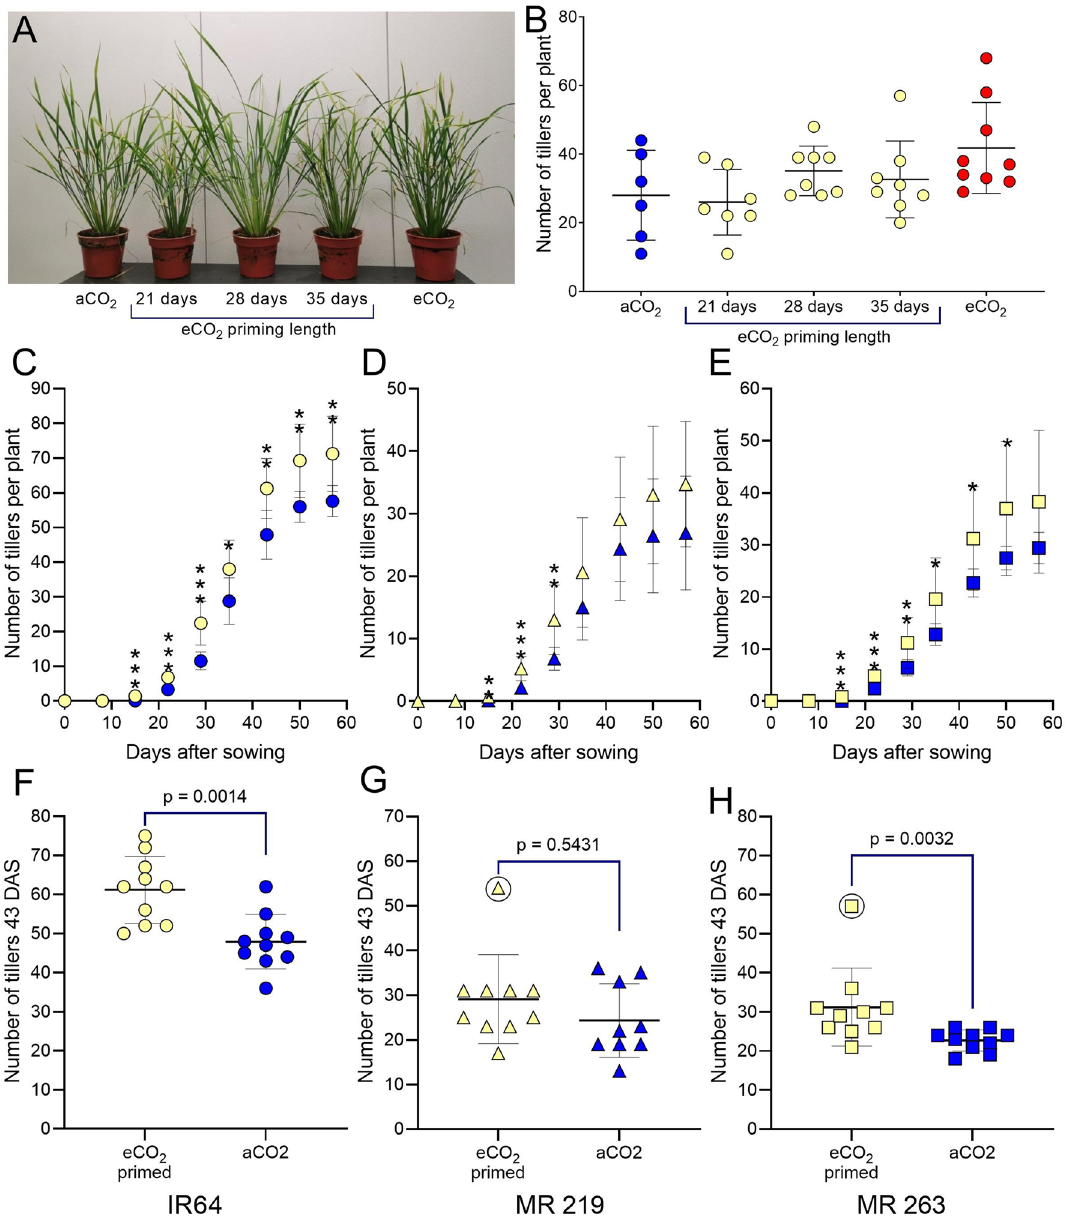
Fig. 1 Phased exposure to eCO 2 leads to increased tillering in rice. A Images of 49 day old IR64 grown in CE chambers. Plants were grown at either aCO 2 , or transferred to aCO 2 from eCO 2 after 21d, 28d, or 35d or grown exclusively at eCO 2 . B Number of tillers per plant at 49 DAS (n 7/8). C , F = IR64‑circles, D , G MR219‑triangles, E , H MR263‑squares. C – E Number of tillers per plant over time. Yellow shapes represent plants eCO 2 ‑primed for 28 days, then transferred to aCO 2 . Blue shapes represent plants grown continuously at aCO 2 . F – H eCO 2 ‑primed IR64 plants ( F ) and MR263 plants ( H ) had more tillers at 43 days after sowing. MR219 plants G did not have a significantly different number of tillers after priming (unpaired t‑test, p values as shown or * p < 0.05, ** p < 0.01, *** p < 0.005, n 9/10). Anomalous results (circled in G, H) are excluded from the statistical =